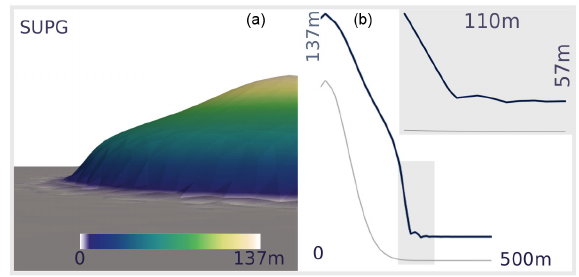
Figure 12. Panel (a) shows the result of the hill test for stabilised simulations after 23 years using the SUPG approach and Crank– Nicholson time discretisation. Panel (b) shows a cross-profile along the y axis of surface (blue) and bed (grey) elevation. The inset shows a zoom of the opaque grey